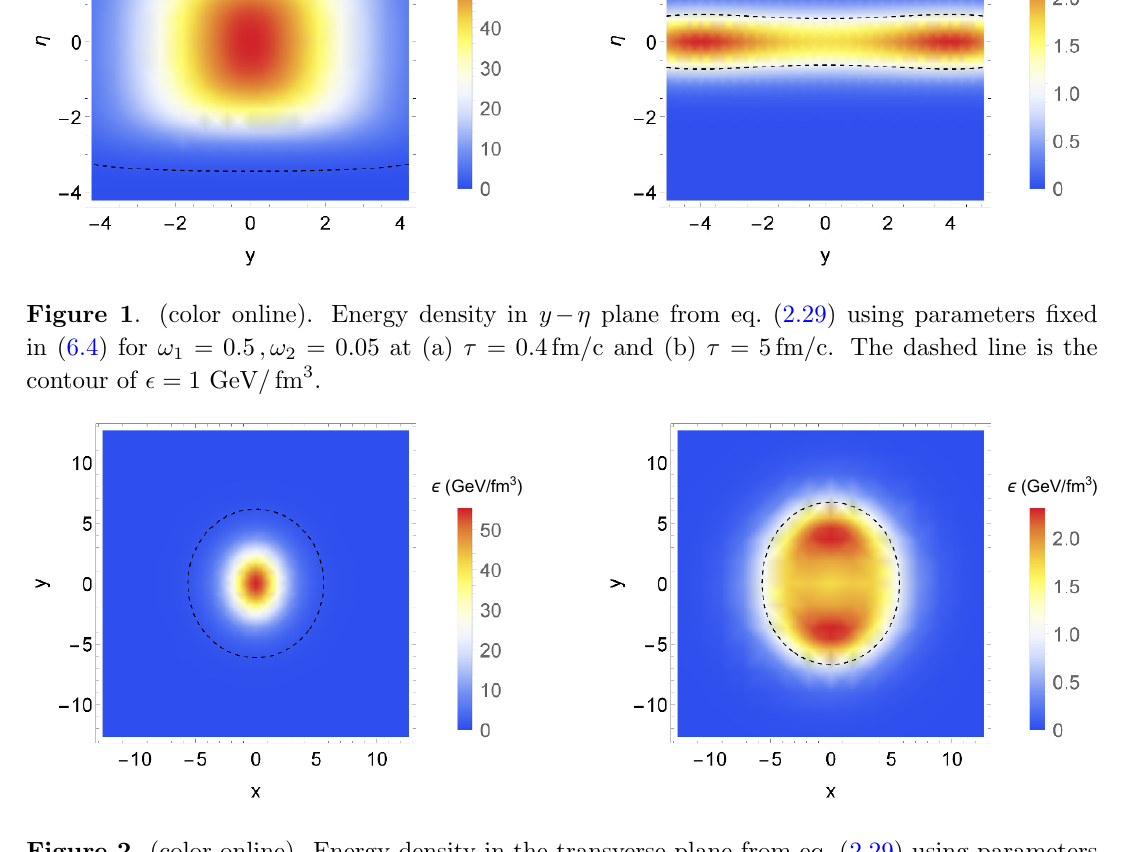
Figure 2 . (color online). Energy density in the transverse plane from eq. (2.29) using parameters (cid:12)xed in (6.4) for ! 1 = 0 : 5 ; ! 2 = 0 : 05 at (a) (cid:28) = 0 : 4 fm = c and (b) (cid:28) = 5 fm = c. The dashed line is the contour of (cid:15) = 1 GeV = fm 3